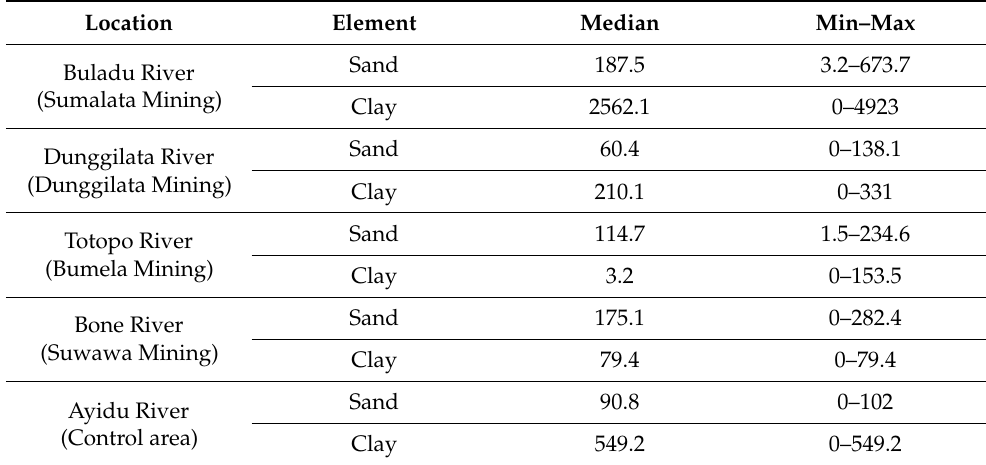
Table 4. Concentration of Zn ( µ g/g) in river sediment sample from ASGM and control